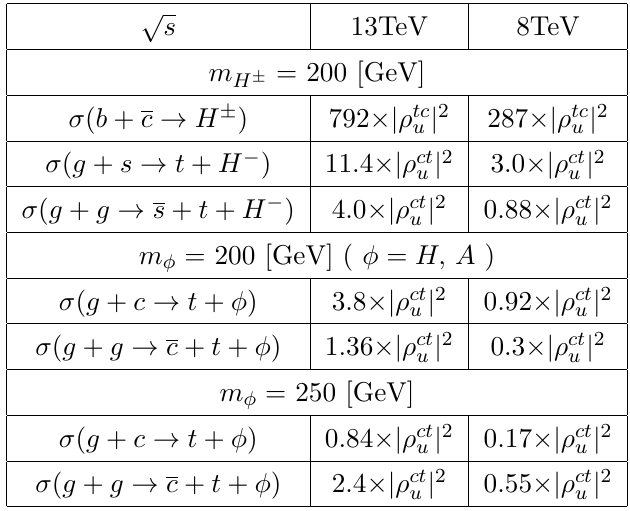
Table 6 . Heavy Higgs Production cross section in pb. We added normal and conjugate cross sections, just as adding (cid:27) ( g + s ! t + H (cid:0) ) and (cid:27) ( g + s ! t + H + ) and denote as (cid:27) ( g + s ! t + H (cid:0) ).